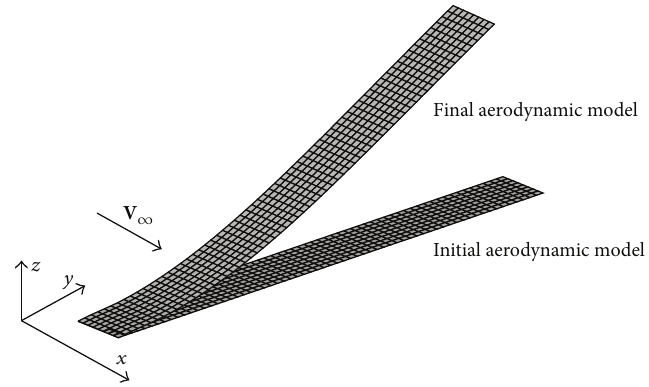
Figure 11: Initial and final aerodynamic model of the flexible wing.